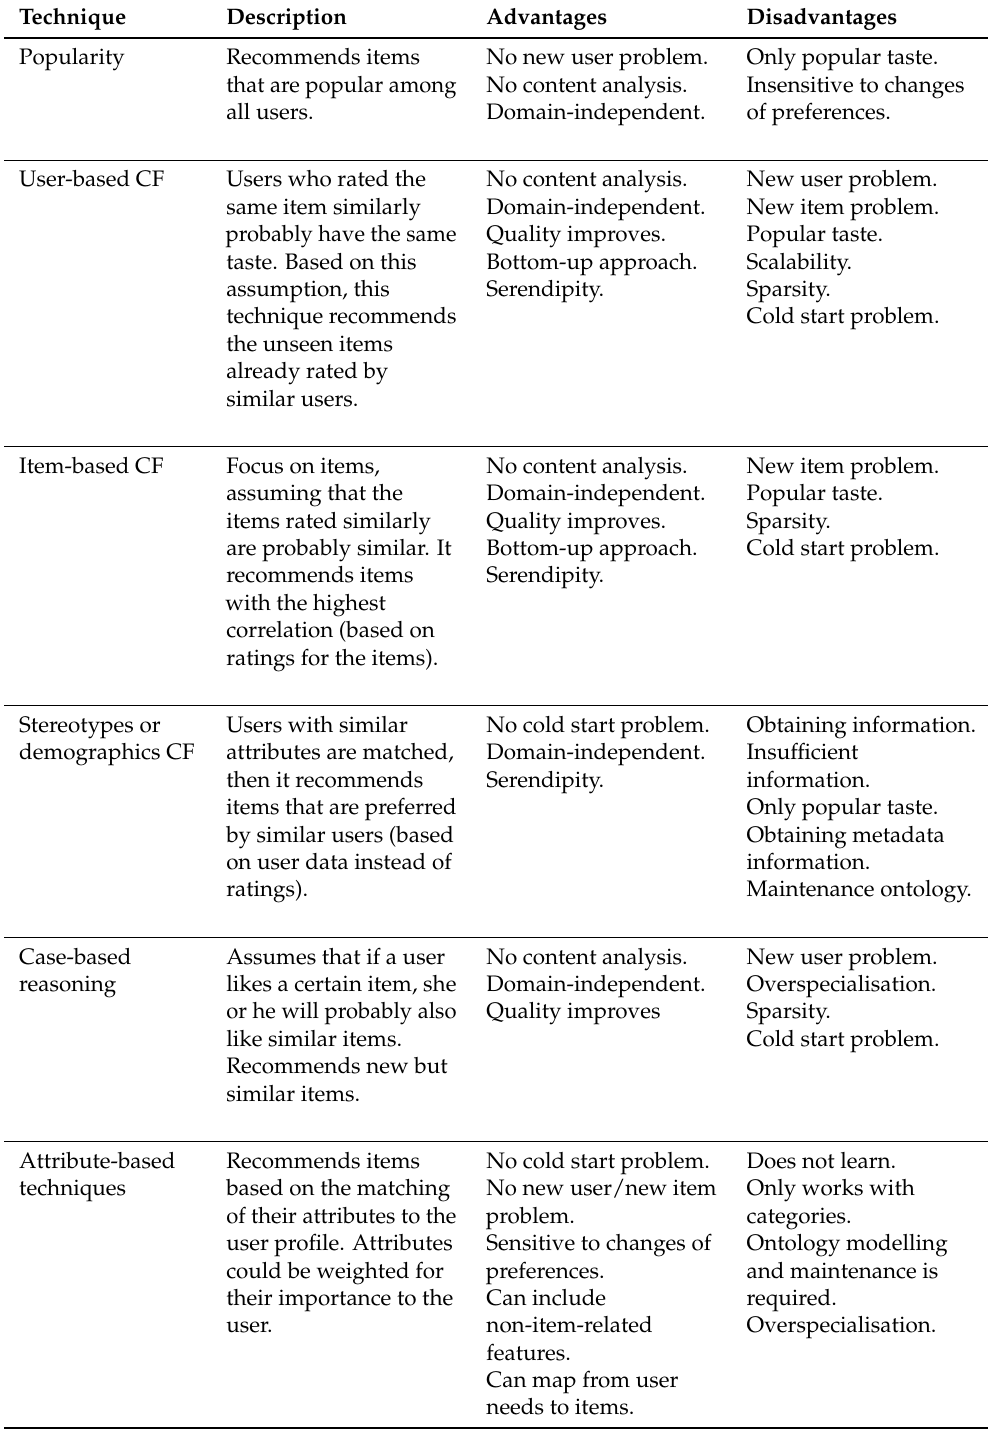
Table 1. Characteristics of main recommendation techniques suitable for technology-enhanced